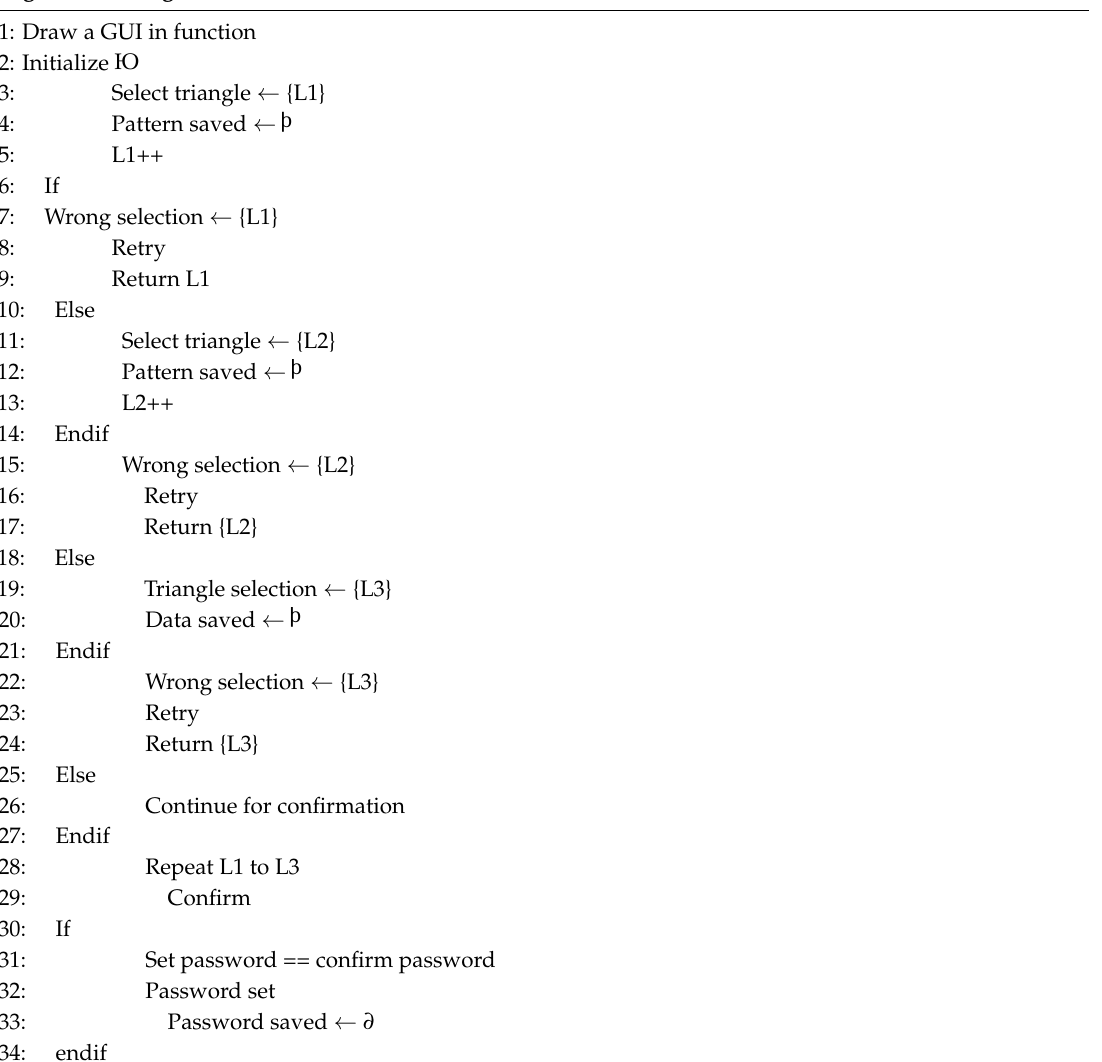
Figure 3 . Sequence diagram for password registration and verification. Algorithm 1. Registration Phase of FBAT Table 2 . Notations.